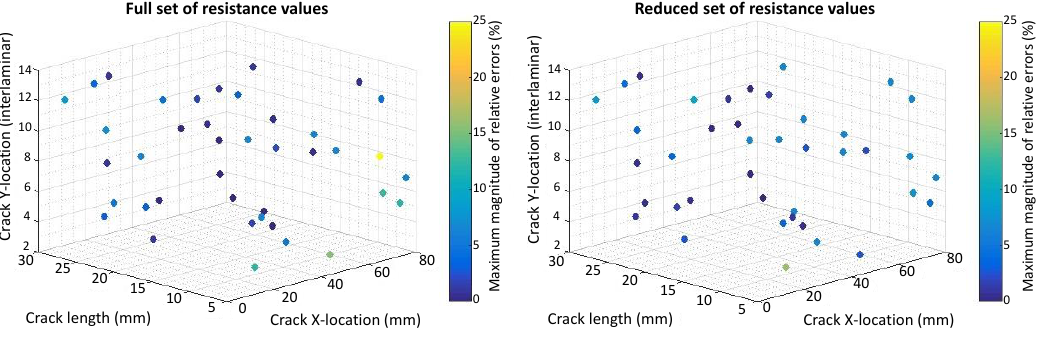
Figure 10. Scatter plot with maximum magnitude of relative errors obtained at the 40 test points used for inverse identification in a [( 0/90 ) resistance measurement set; ( right ) Reduced resistance measurement set using